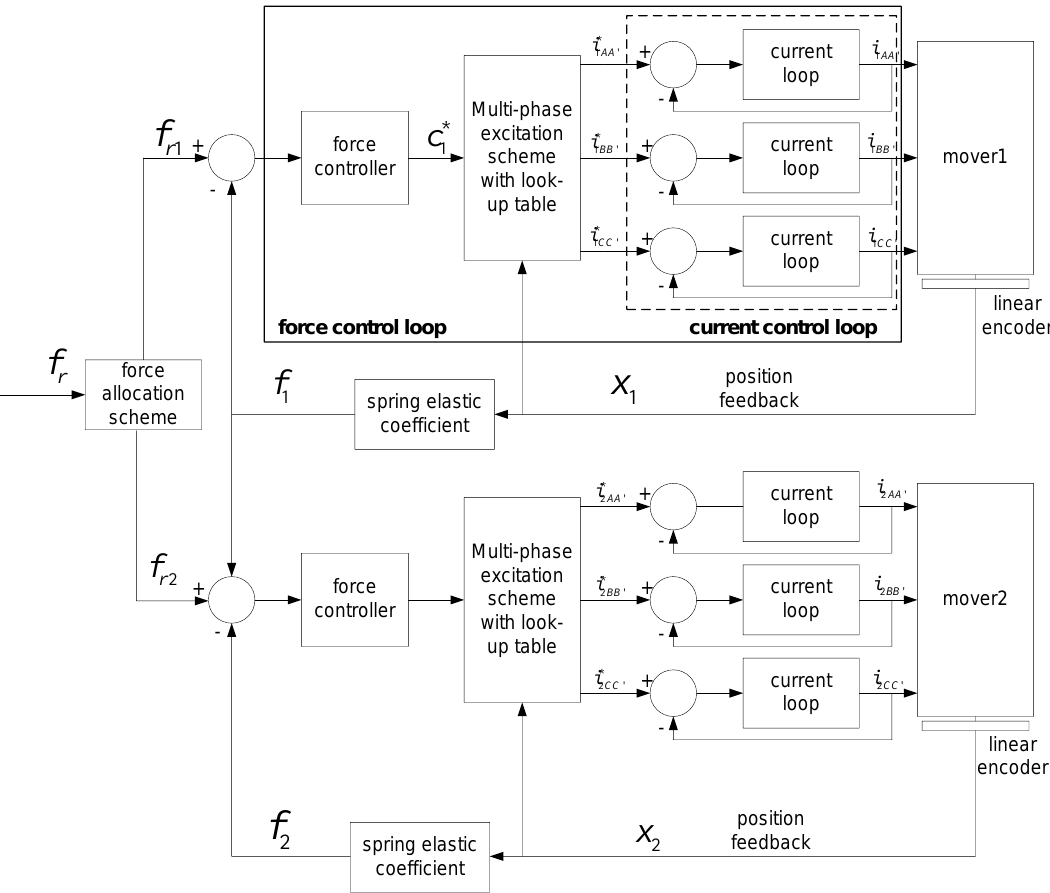
Figure 2. Diagram of the complimentary force control scheme. Table 2. Multi-phase excitation scheme for each